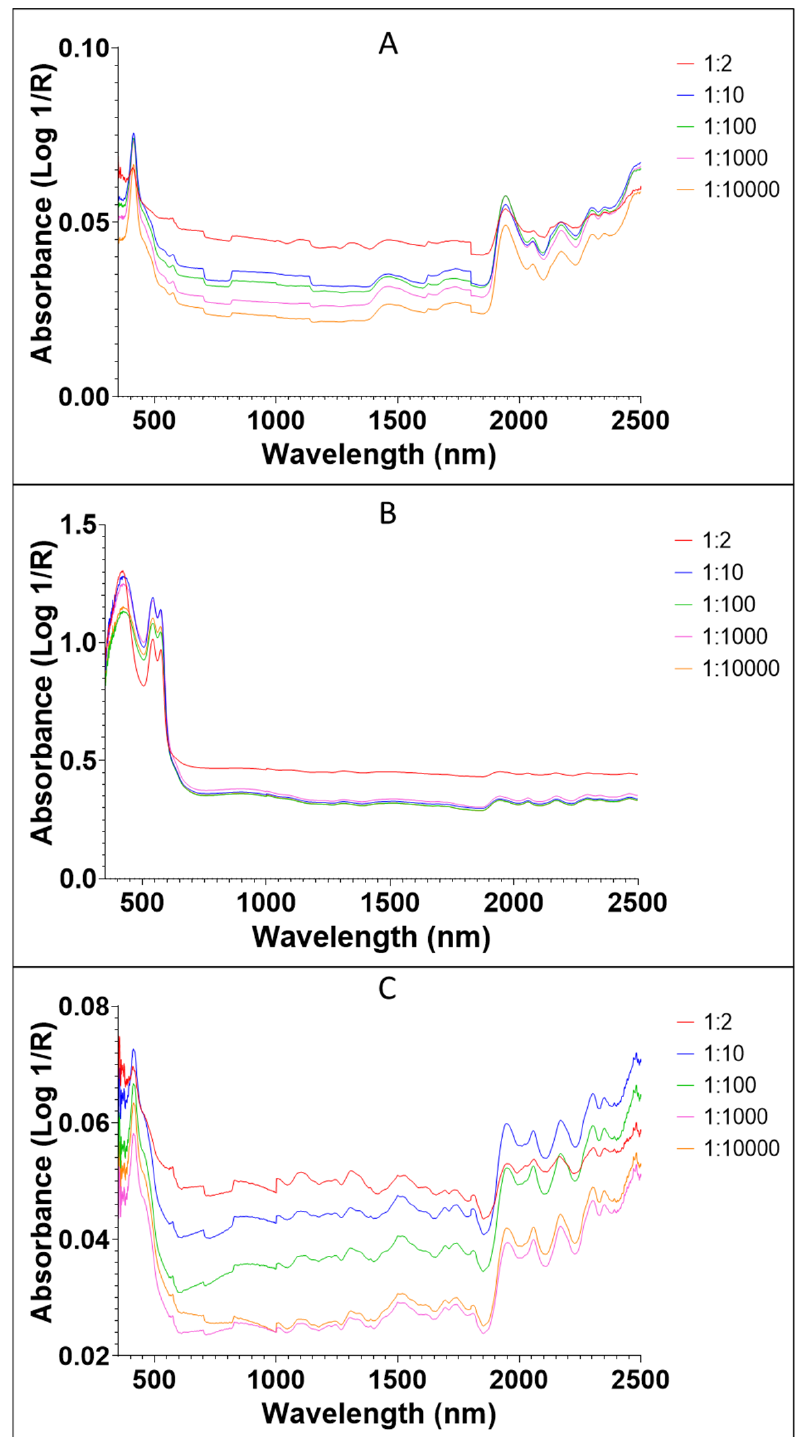
Figure 3. NIR spectra of all DENV1-infected samples split by concentration for plasma ( A ), whole blood ( B ) and serum ( C ). Each spectrum is an average of all spectra collected from multiple donors for the dilution shown. Initial concentration of DENV1 was 3.16 × 104 infectious unit/µL.